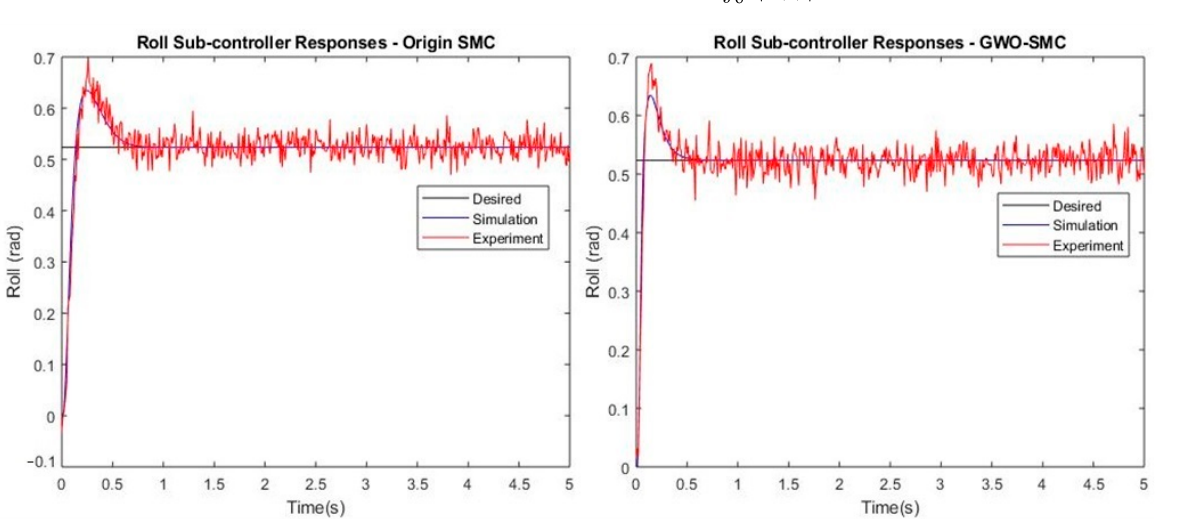
Figure 8. Comparison between original and GWO improved roll sub ‐ controller in the experiment.